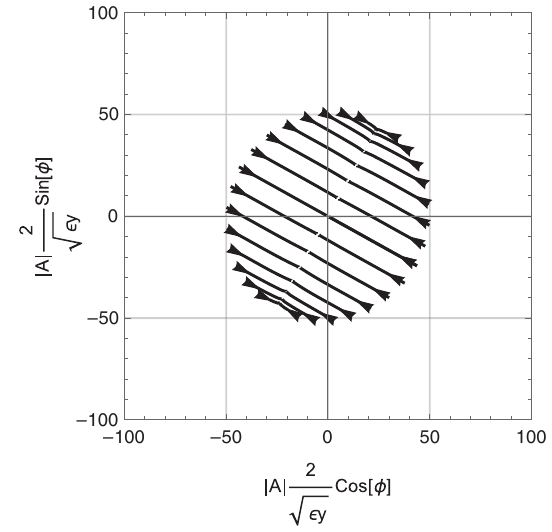
FIG. 16. Evolution of the average particle trajectories, solu- tion of Eqs. (A4) and (A5) with the same initial amplitude and different initial phases. Initial amplitude corresponds to 0 Þ ¼ 50 σ y 0 ð φ , with small modulation amplitude. y ¼ y